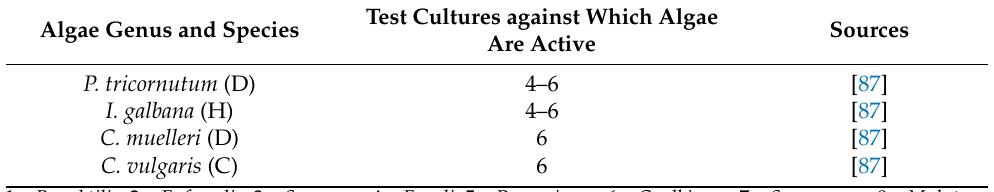
Test Cultures against Which